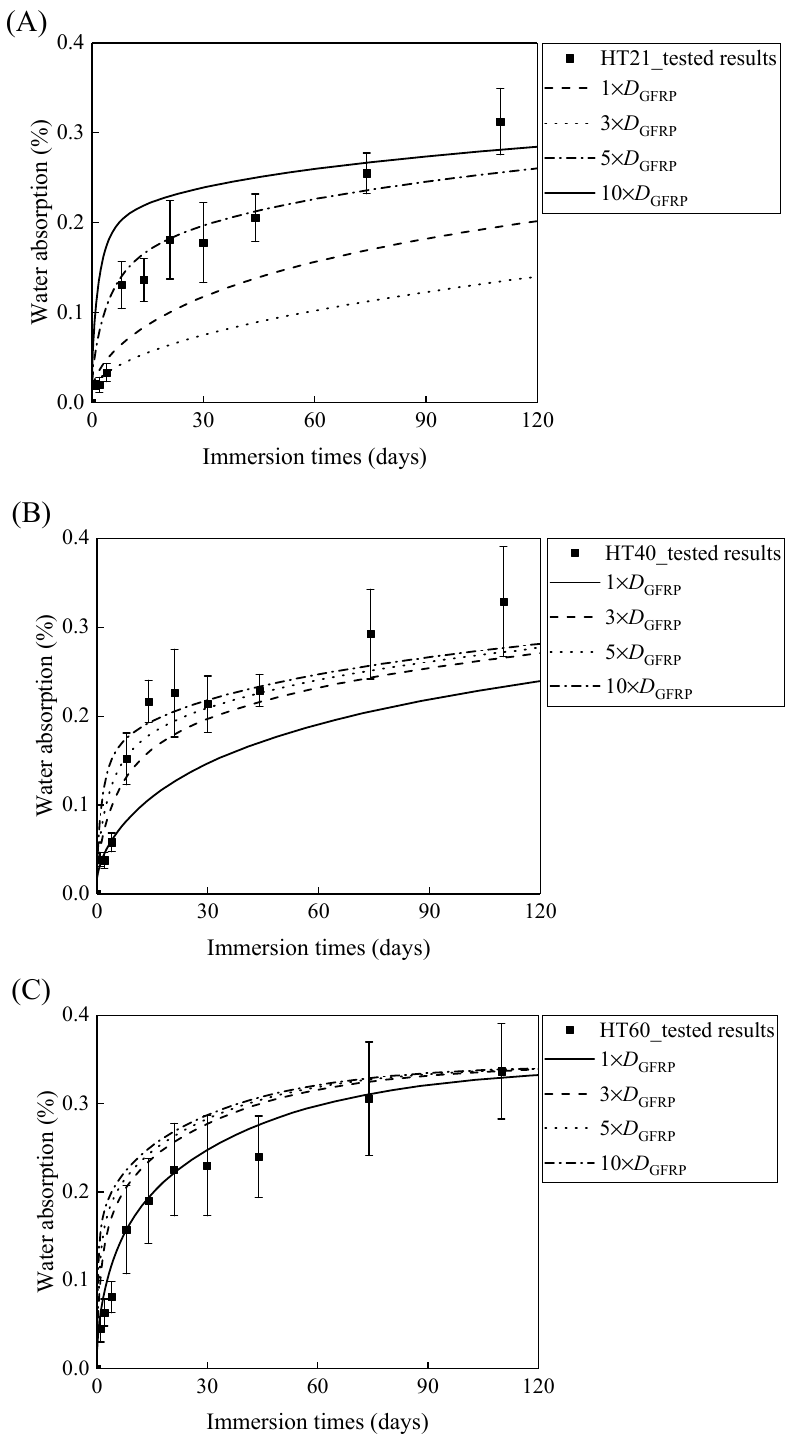
Figure 7. The variation in the water absorption of the HFRP bars with the immersion time at various temperatures for the determination of the radial diffusivity coefficient of the carbon fiber coat: ( A ) 21 °C, ( B ) 40 °C, and ( C ) 60 °C.